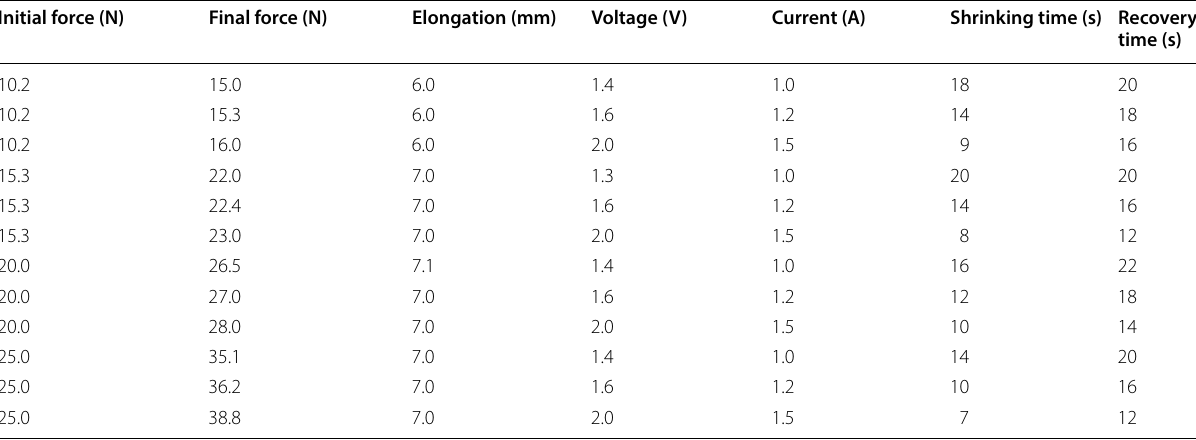
Table 3 Experimental results of the SMA Initial force